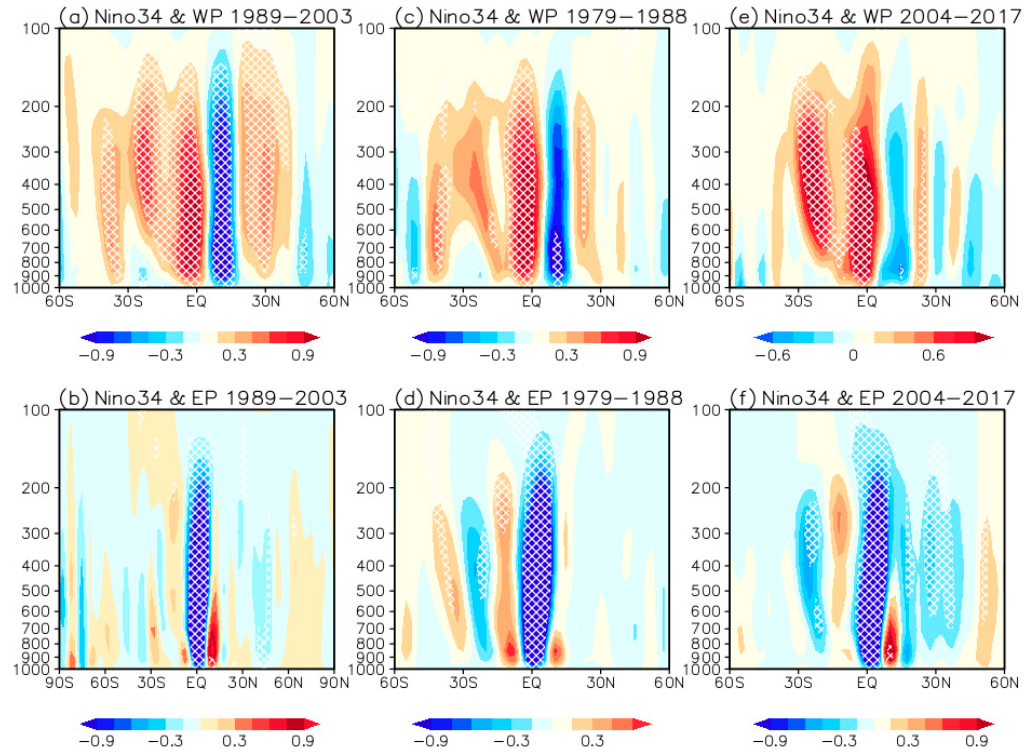
Figure 10. Linear regression maps of the Niño3.4 index with the zonally averaged (120° E – 155° E) vertical field of the summer vertical velocity (omega) in the western Pacific region during ( a ) 1989 – 2003; ( c ) 1979 – 1988; and ( e ) 2004 – 2017. ( b , d , f ) same as ( a , c , e ) but for the zonally averaged (180° – 100° W) vertical summer omega field in the eastern Pacific region (unit P/s); the vertical velocity has been multiplied by 100. The gridded regions indicate that the correlations are positively and negatively significant at the 95% confidence level.